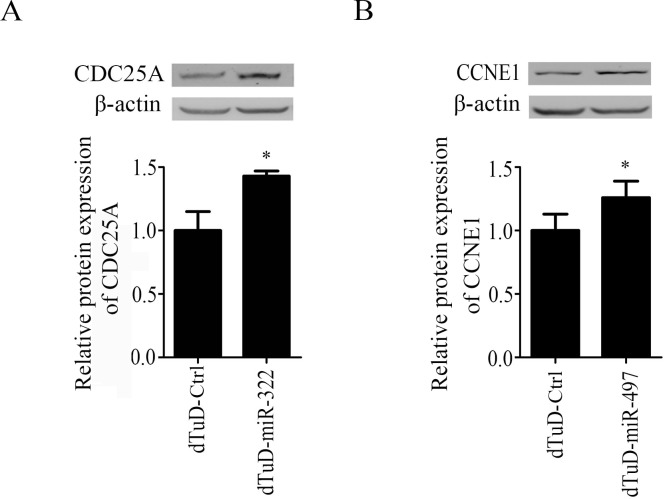
Inhibitory effects of dTuDs on protein expression of miRNA target.The protein expression level of CDC25A (A) or CCNE1 (B) in C2C12 cells transduced with lentivirus expressing dTuD-miR-322 or dTuD-miR-497, respectively. CDC25A and CCNE1 are validated target genes of miR-322 and -497, respectively. The protein expression level was normalized to that of dTuD-Ctrl. Data were represented as the mean ± SD (n = 3).* p < 0.05.